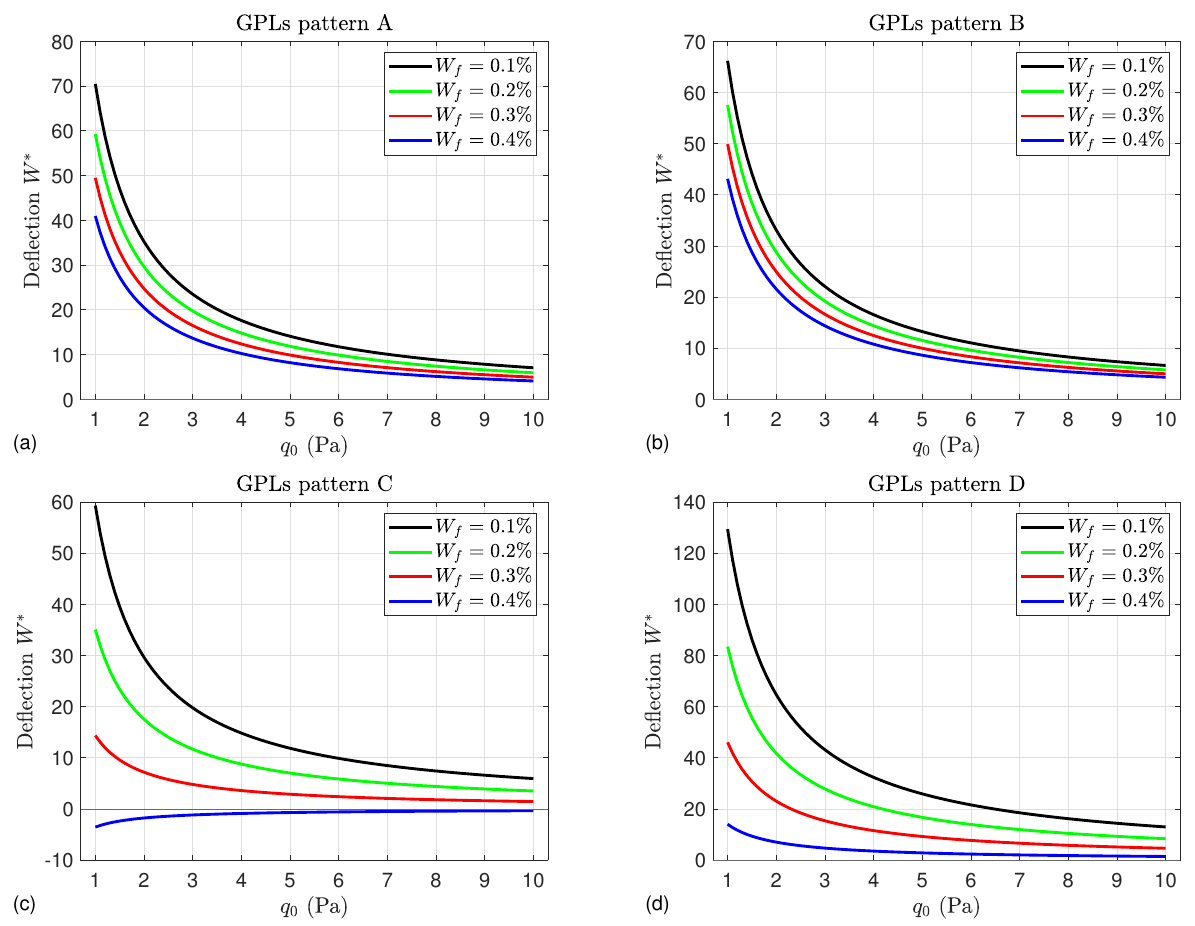
Figure 8. Influence of the GPLs weight fraction W f on the central deflection W ∗ of FG porous nanocomposite piezoelectric square plates for different graphene distribution patterns: ( a ) Pattern A, ( b ) Pattern B, ( c ) Pattern C and ( d ) Pattern